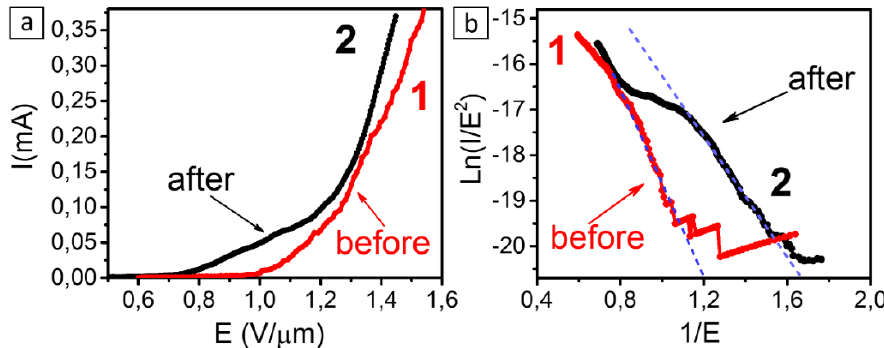
Figure 6. Current–voltage (I–V) characteristics measured for the initial and plasma-treated CNT arrays ( a ). The curves plotted in the Fowler-Nordheim coordinates ( b ).